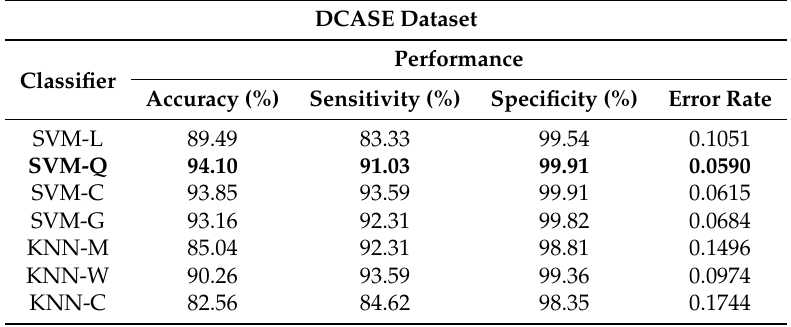
Table 4. Performance of various classifiers for proposed feature extraction approach for DCASE dataset.